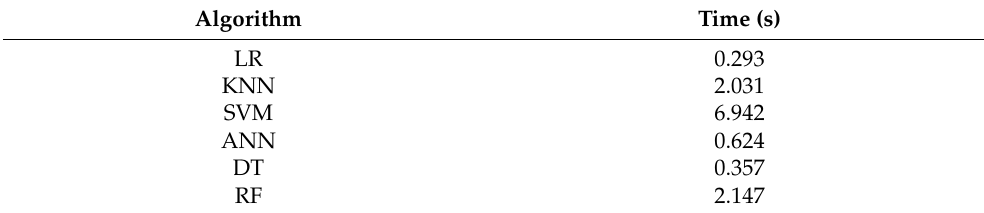
Table 5. Algorithm execution